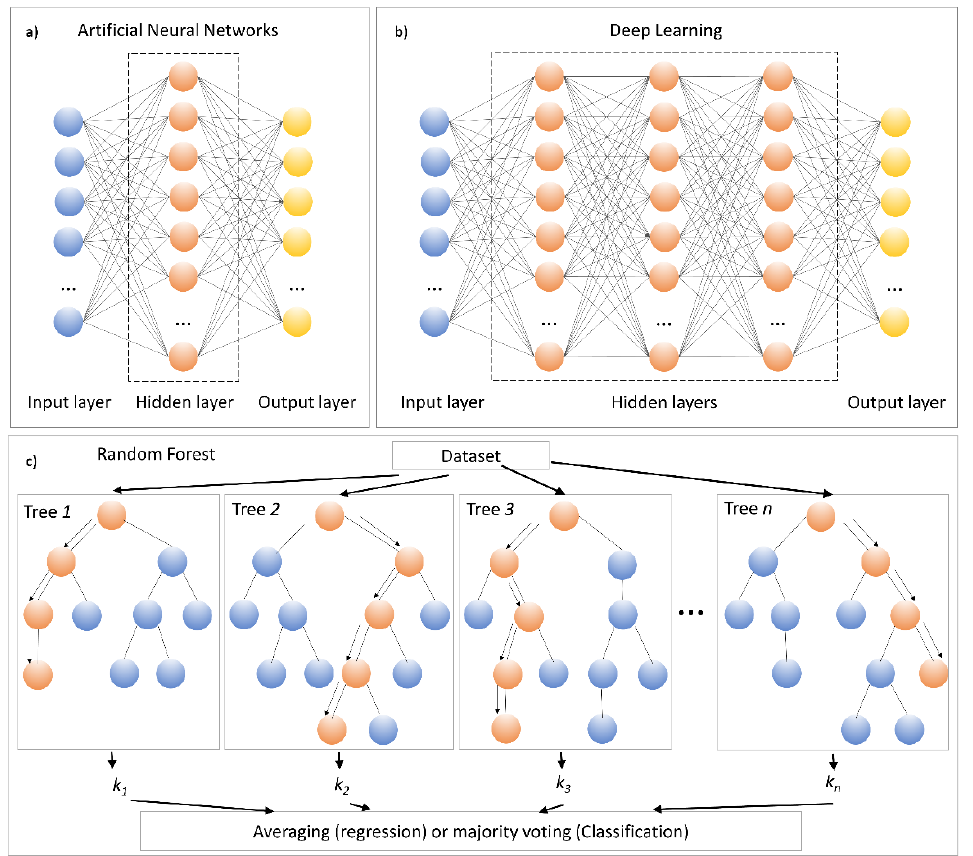
Figure 1. Different machine learning architectures: ( a ) artificial neural networks, ( b ) deep learning, and ( c ) random forest.